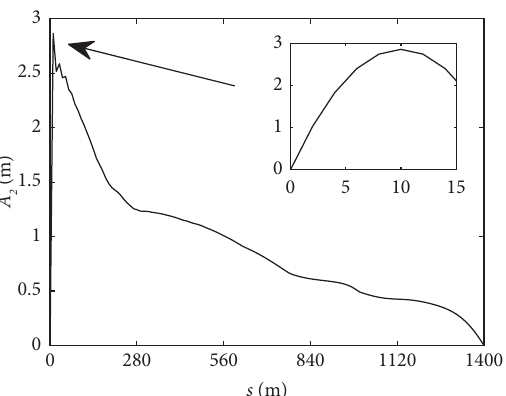
Figure 5: Amplitude distribution of normal motion of mooring line.